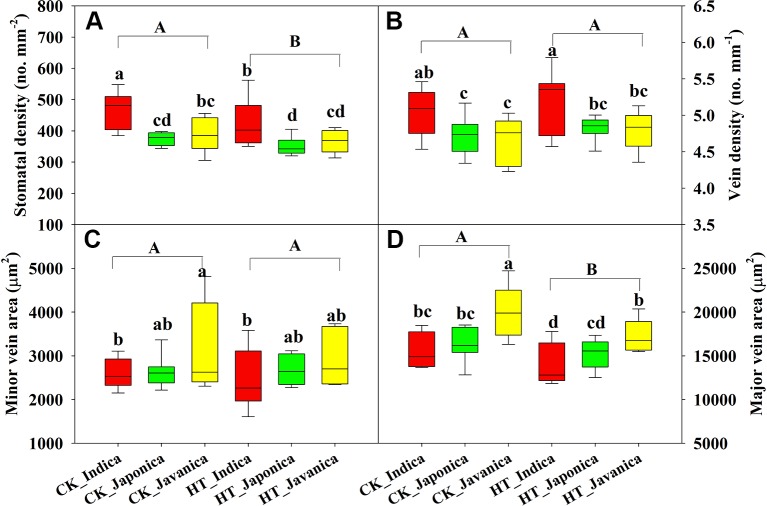
Stomatal density (A), vein density (B), and vein area of minor (C), and major (D) veins for the three rice (Oryza sativa L.) subspecies at high growth temperature (HT) and control (CK) treatments. Different lowercase and uppercase letters indicate significant differences between subspecies means and temperature treatments, respectively (p < 0.05). The outer box edges represent the 25th and 75th percentiles, the error bars are the 5th and 95th percentiles, and the line within the box represents the mean values. For each cultivar, three flag leaves were measured (one leaf per plant), and the three values were averaged as one biological replicate. n (the biological replicates) was 8, 8, and 5 for the indica, japonica, and javanica cultivars, respectively.